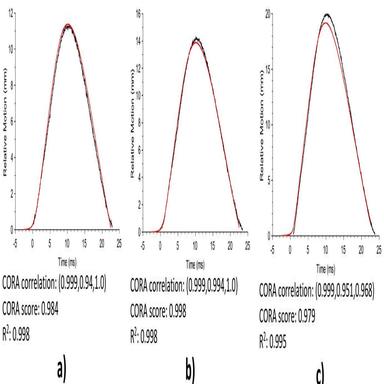
Comparison of experimental (in black) and simulated (in red) gel bulge time courses for impact velocities of a) 0.83 m/s, b) 1.08 m/s, and c) 1.44 m/s for Sylgard 527 (1:1). CORA scores as well as R2 values are provided. Material parameters used for the simulated data were derived from the 0.83 m/s impact velocity experiment.